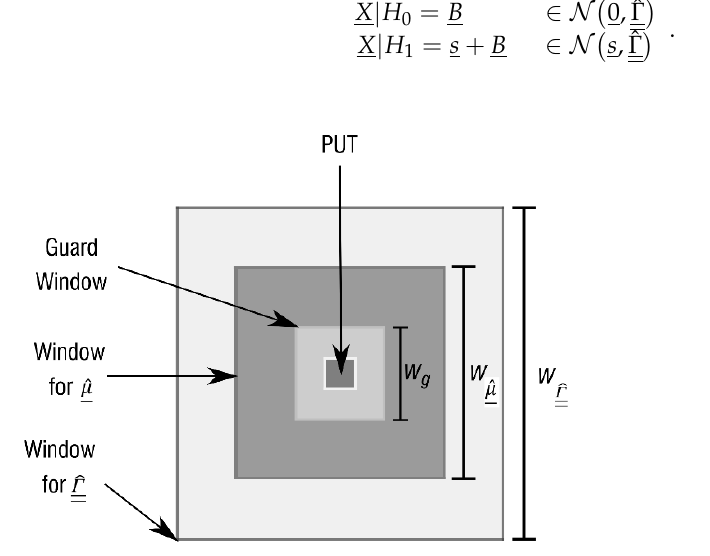
Figure 6. Geometrical principle of local RX detector with three specific sliding windows: guard window and windows for calculation of ˆ µ and ˆ Γ , with their respective widths w g , w ˆ µ and w ˆ Γ . Detection statistic is calculated in a convolutional manner using the squared Mahalanobis dis- tance.